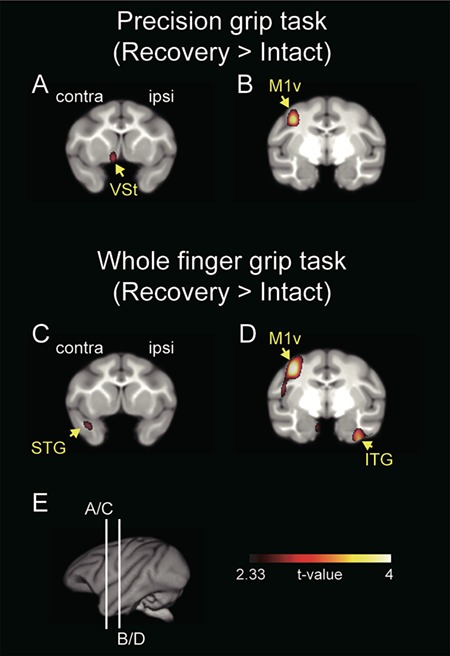
Increased brain activation related to functional recovery during the precision grip task and whole finger grip task. (A–D) Results show averaged data from the three monkeys (Monkeys H, K, and TF). Brain areas with significantly increased rCBF (P < 0.01, uncorrected for multiple comparisons) are superimposed on a template brain MRI of macaque monkeys. Other brain areas showing significant increased activation are presented in Supplementary Figure 2 and Supplementary Table 4. Coronal sections including the VSt are shown in (A) and (C). Coronal sections including the M1 are shown in (B) and (D). The significance level is in terms of t-values represented on a color scale. (E) Lines (A/C) and (B/D) indicate the levels of coronal sections A/C and B/D, respectively. Contra, contralesional; ipsi, ipsilesional; M1v, ventral aspect of the primary motor cortex; STG, superior temporal gyrus; ITG, inferior temporal gyrus.